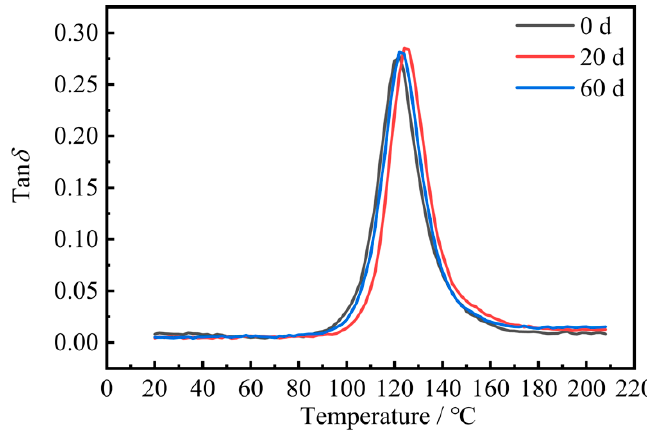
Figure 12. CFRP loss factor–temperature curve.